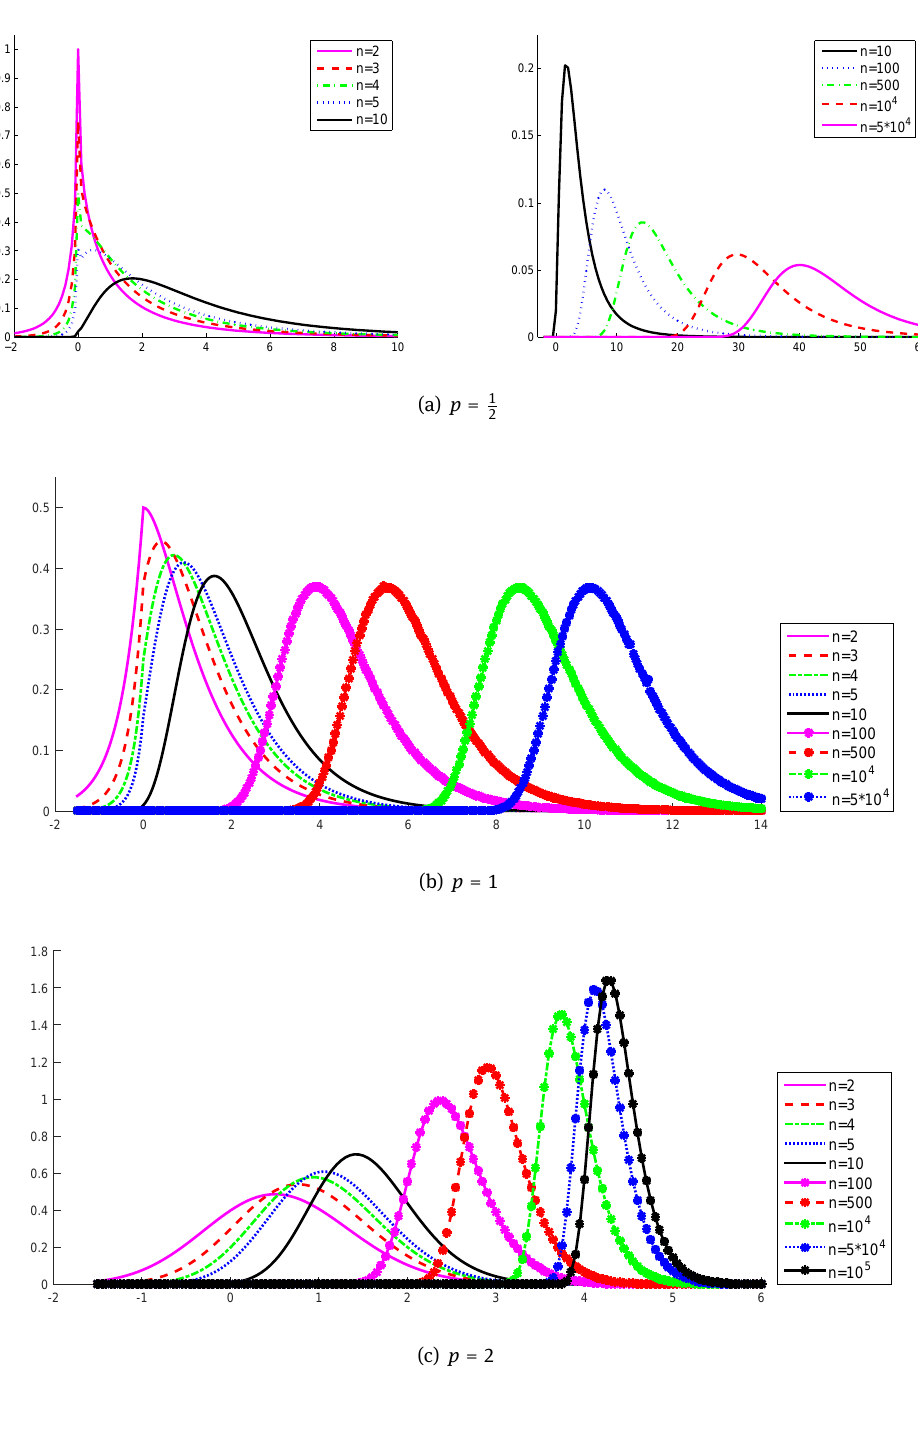
show the regions of intersection between the black and the green solid, the black and the green dashed, and the green solid and the green dashed graphs, being approximately { −8; 52 } , { −12; 81 } , and { −23; 153 } ,